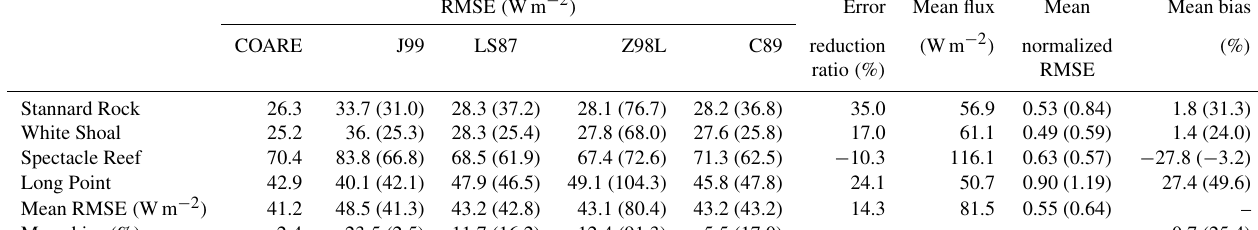
Table 2. Statistics of simulated latent heat flux λE for 2012–2014. For J99, LS87, Z98L, and C89, RMSEs with the updated z 0 θ,q formulation are shown. Numbers in parentheses denote RMSEs with the original z 0 θ,q formulation. An error reduction ratio (%) is calculated for mean RMSEs of J99, LS87, Z98L, and C89. A mean flux (Wm − 2 ) and mean normalized RMSEs are calculated for all the five algorithms.